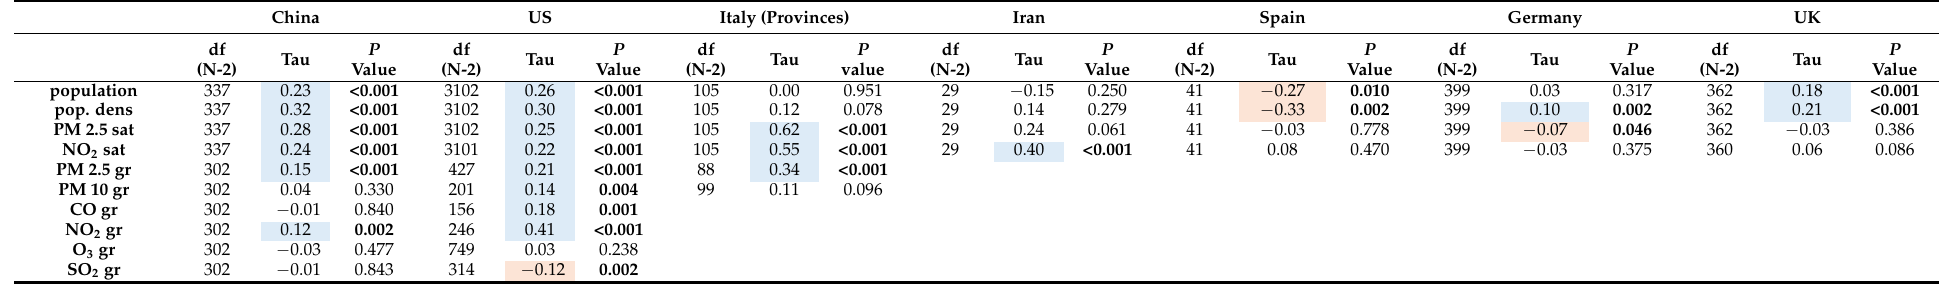
Table 2. Correlation coefficients between COVID-19 infections per 100,000 inhabitants and air quality variables. Significant Kendall correlations with p -values < 0.05 are shown in bold; blue and red shadings indicate positive and negative correlations, respectively.